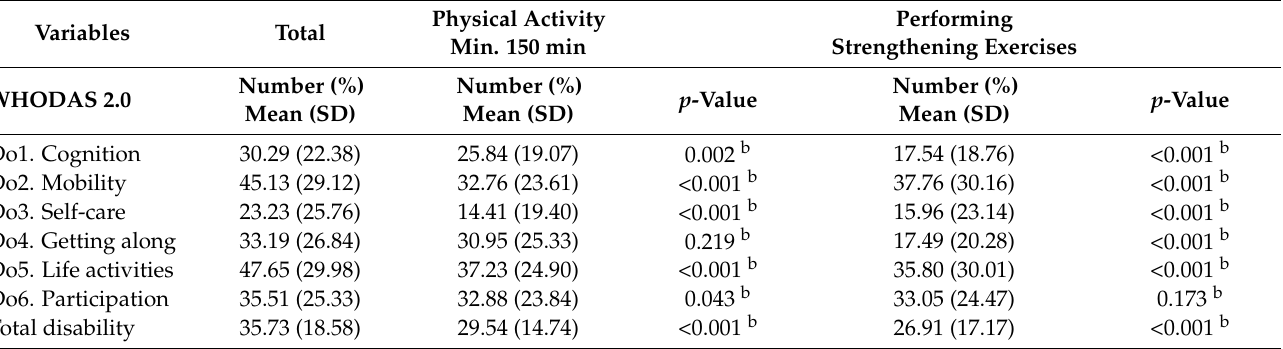
Table 2. Characteristics level of disability of people aged 75–90 years ( n =